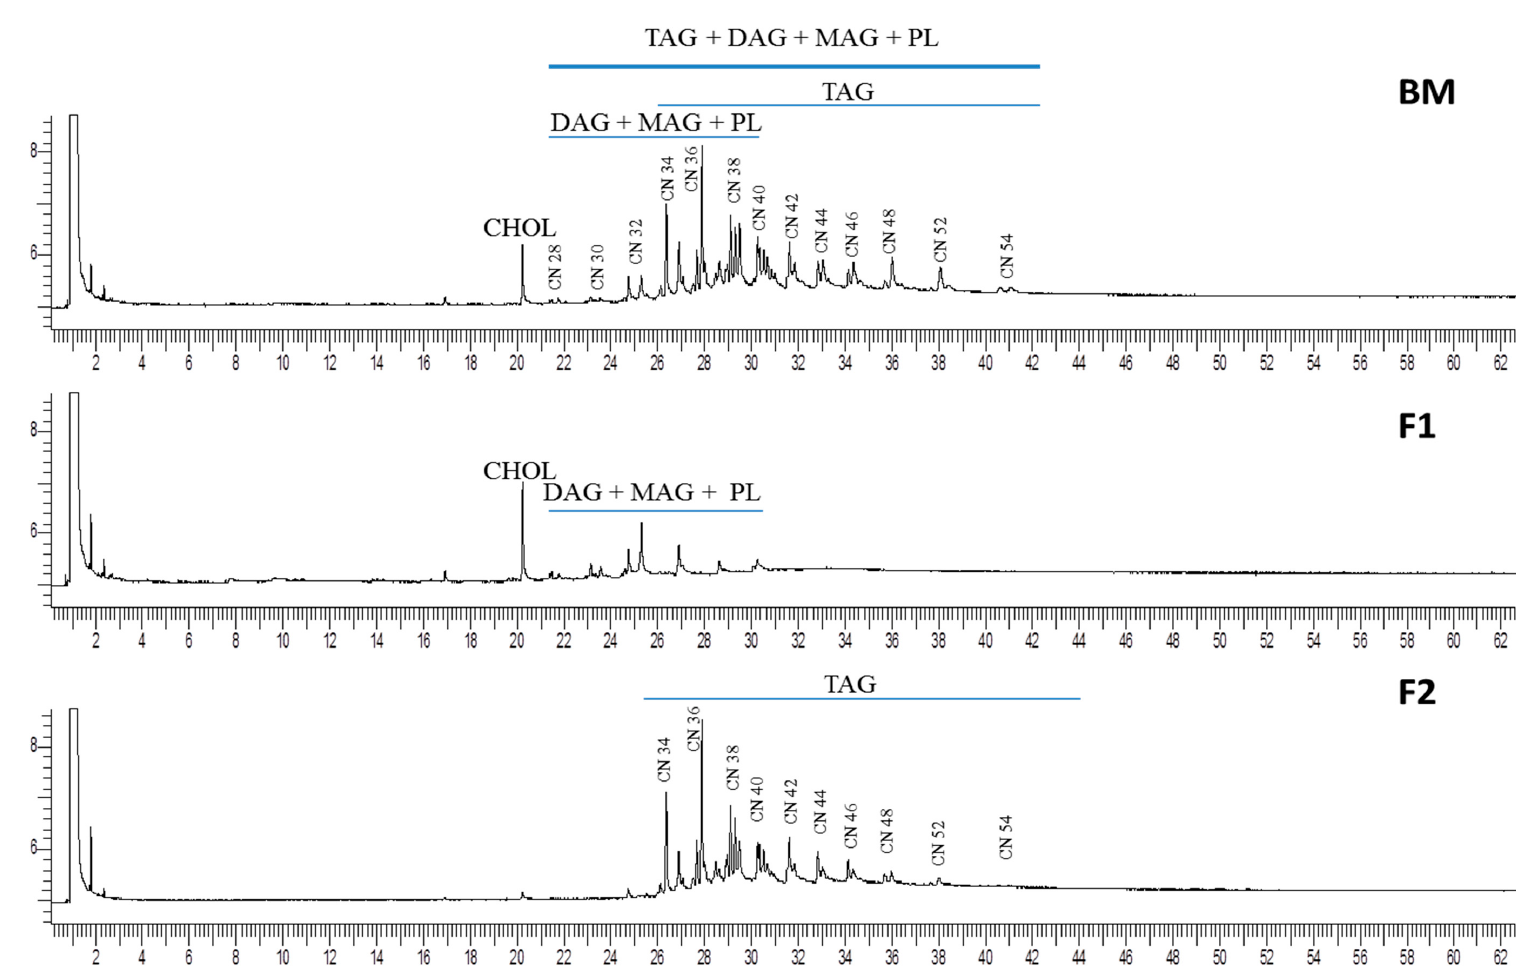
Figure 2. Chromatographic profile of lipid classes (DAG, diacylglycerides; CHOL, cholesterol; MAG, monoacylglycerides; PL, polar lipids) and molecular species of triacylglycerides (TAG) by carbon number (CN) of buttermilk (BM) and isolated fractions F1 and F2 determined by GC-FID.